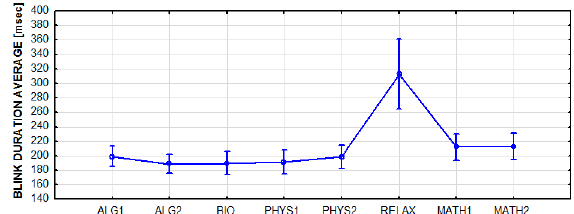
Figure 5. The blink duration average – a distribution of the mean values for the particular tasks and the relax time.